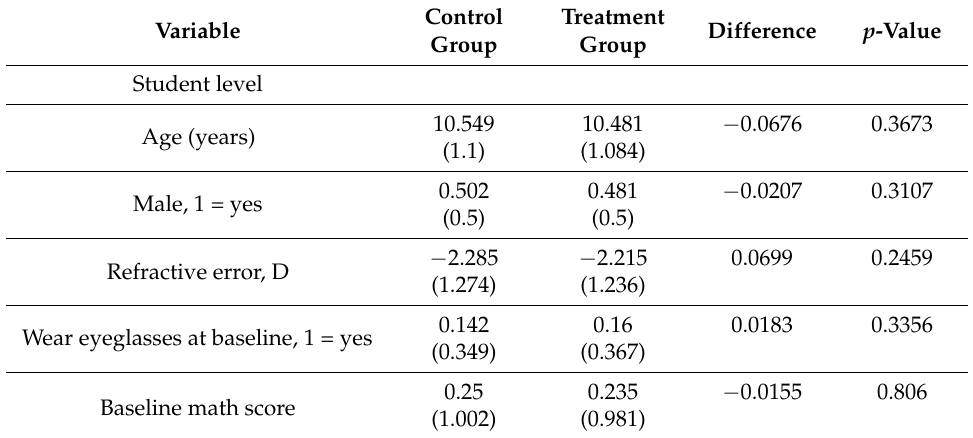
Table A2. Balance check of baseline characteristics of the remaining sample across experimental